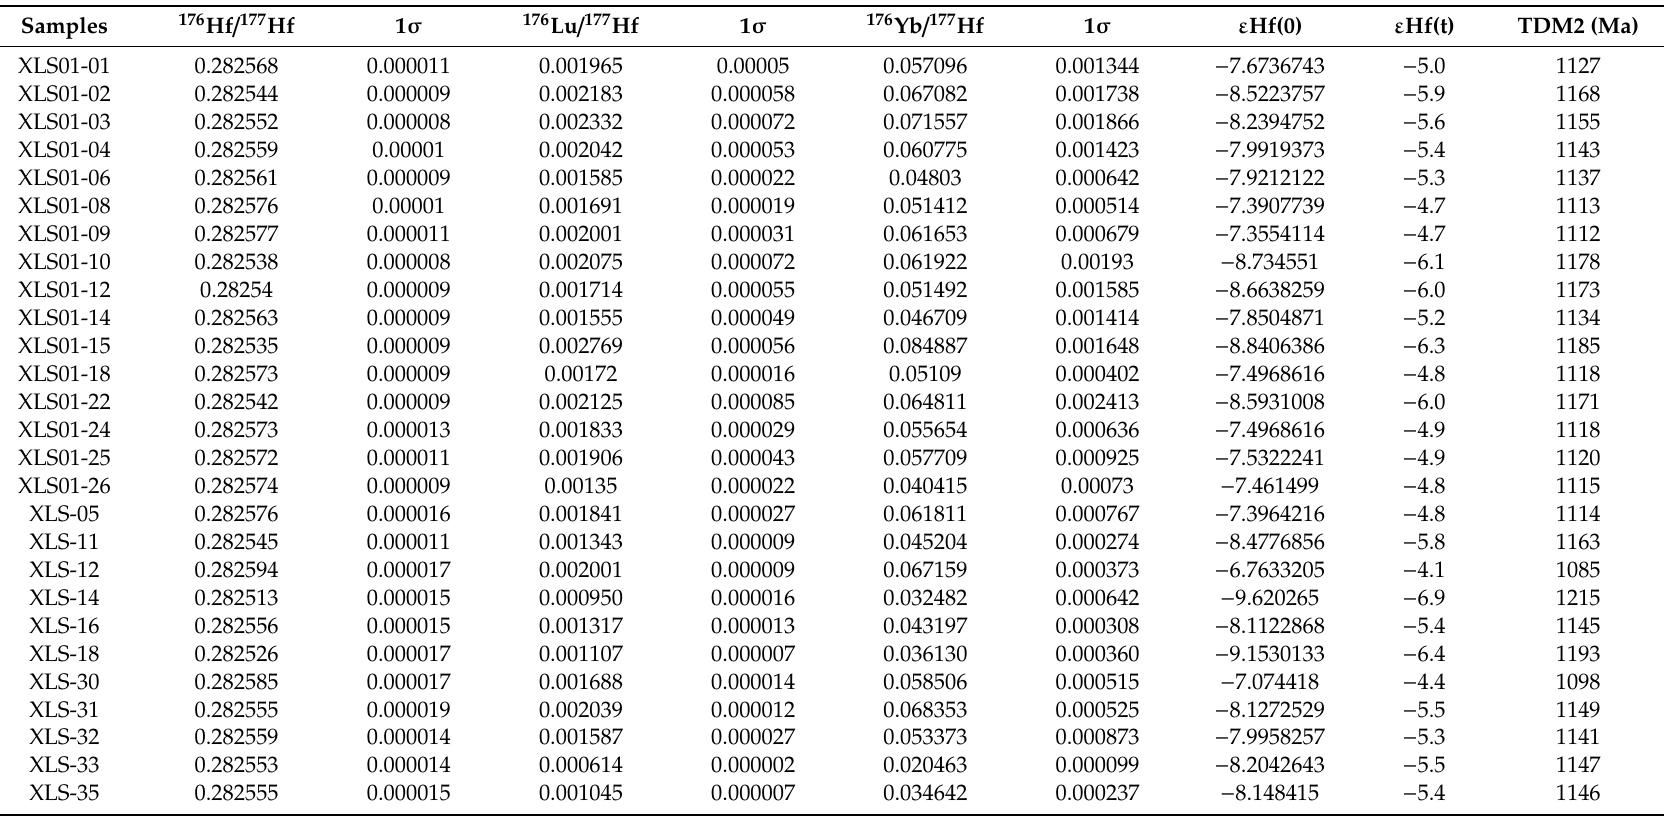
Table 2. Zircon Hf isotopes of the Xianglushan biotite